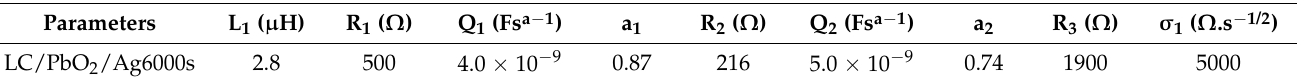
Table 3. Best-fitting parameters for sample LC/PbO 2 /Ag6000s according to the circuit shown in Figure 5c.